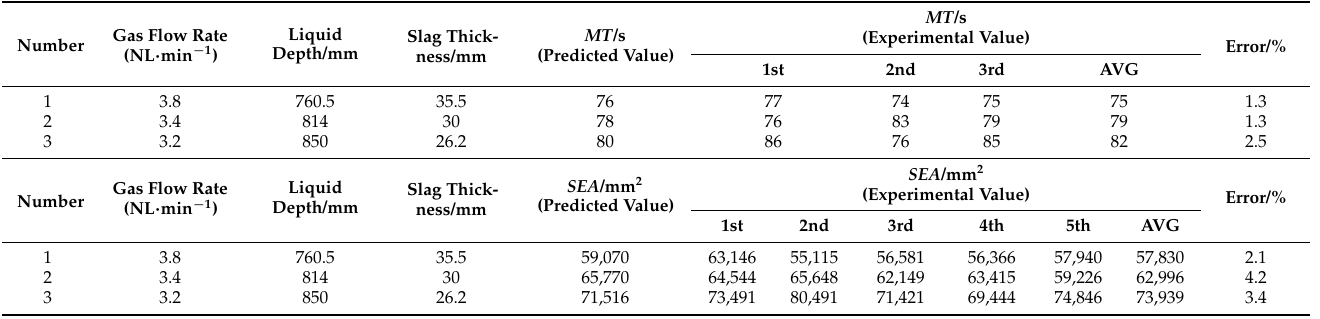
Table 11. Predicted and experimental values under optimal